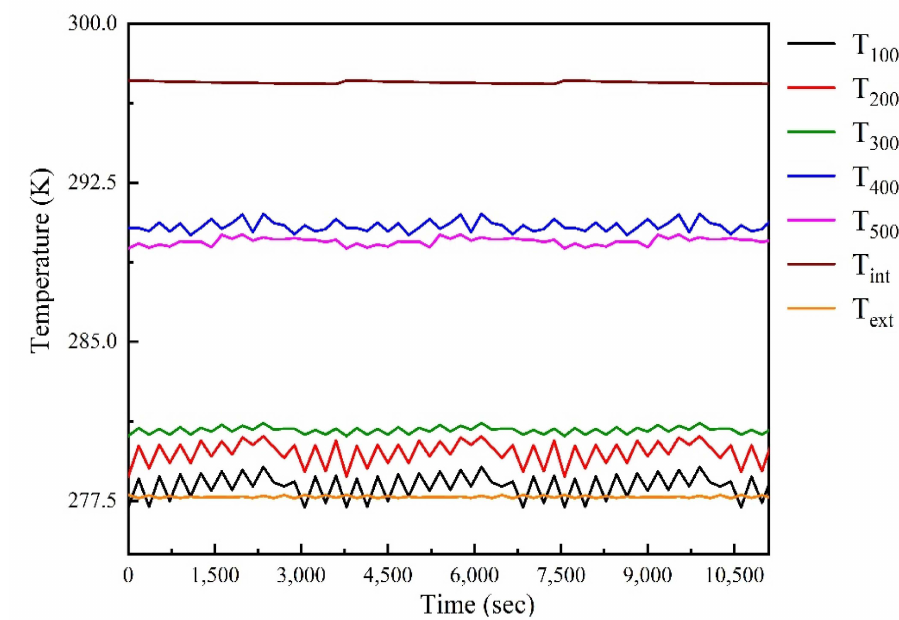
Figure 7. Variations in air temperature measurements during data acquisition.